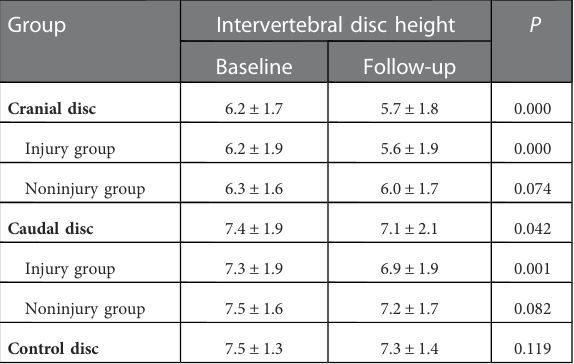
TABLE 2 Changes in intervertebral disc height in the cranial, caudal and control